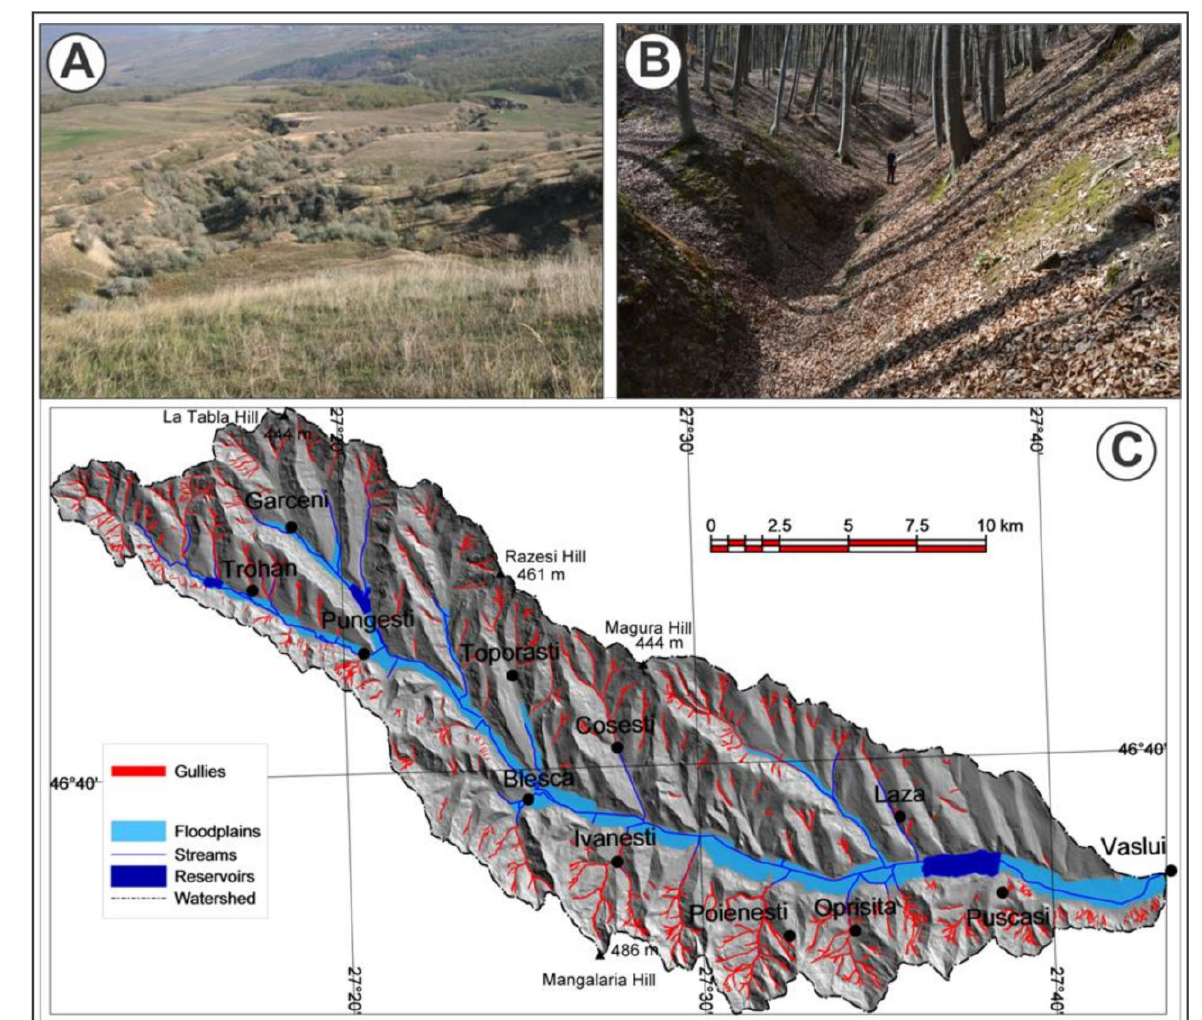
Figure 4. Continuous gullies incised in the upper Poienesti sub-catchment on 20 October 2013 ( A ), new discontinuous incisions in an old V-shaped gully from Oprisita forest on 4 April 2016 ( B ), and map of gully distribution in the Racova Catchment ( C